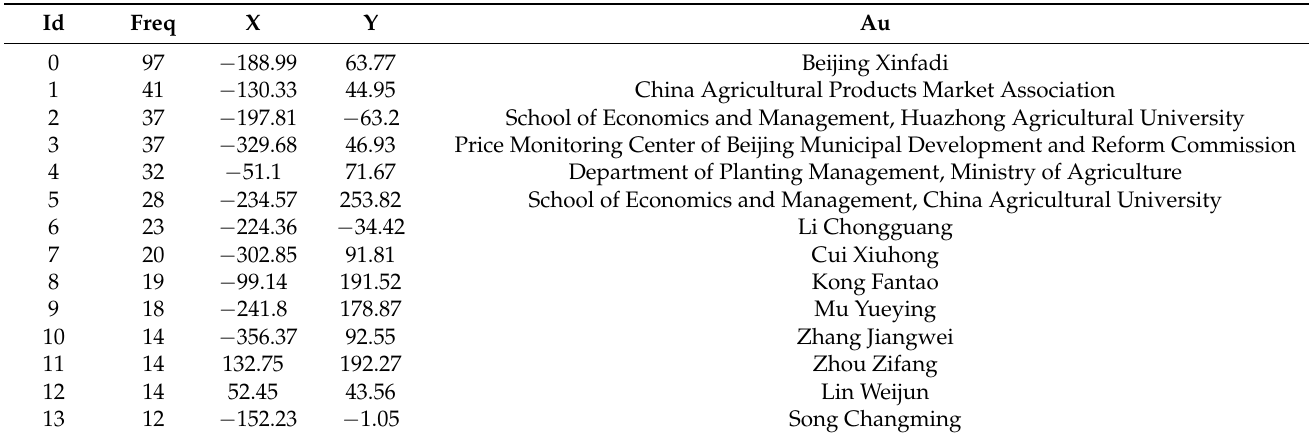
Table 2. Ranking of CNKI Cooperative Citations.